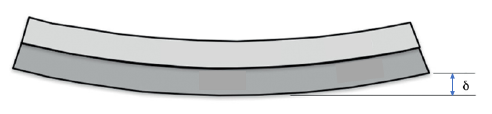
Figure 6. Scheme of the deformation phenomenon, quantified as δ